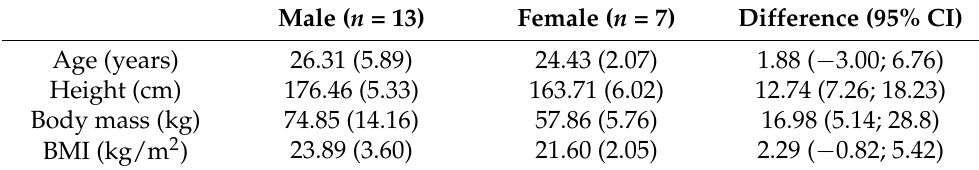
Table 1. Demographic